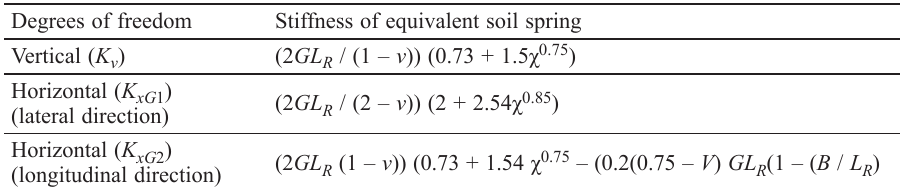
Table 1. Stiffness of equivalent springs along various degree of freedom (Gazetas 1991) Degrees of freedom